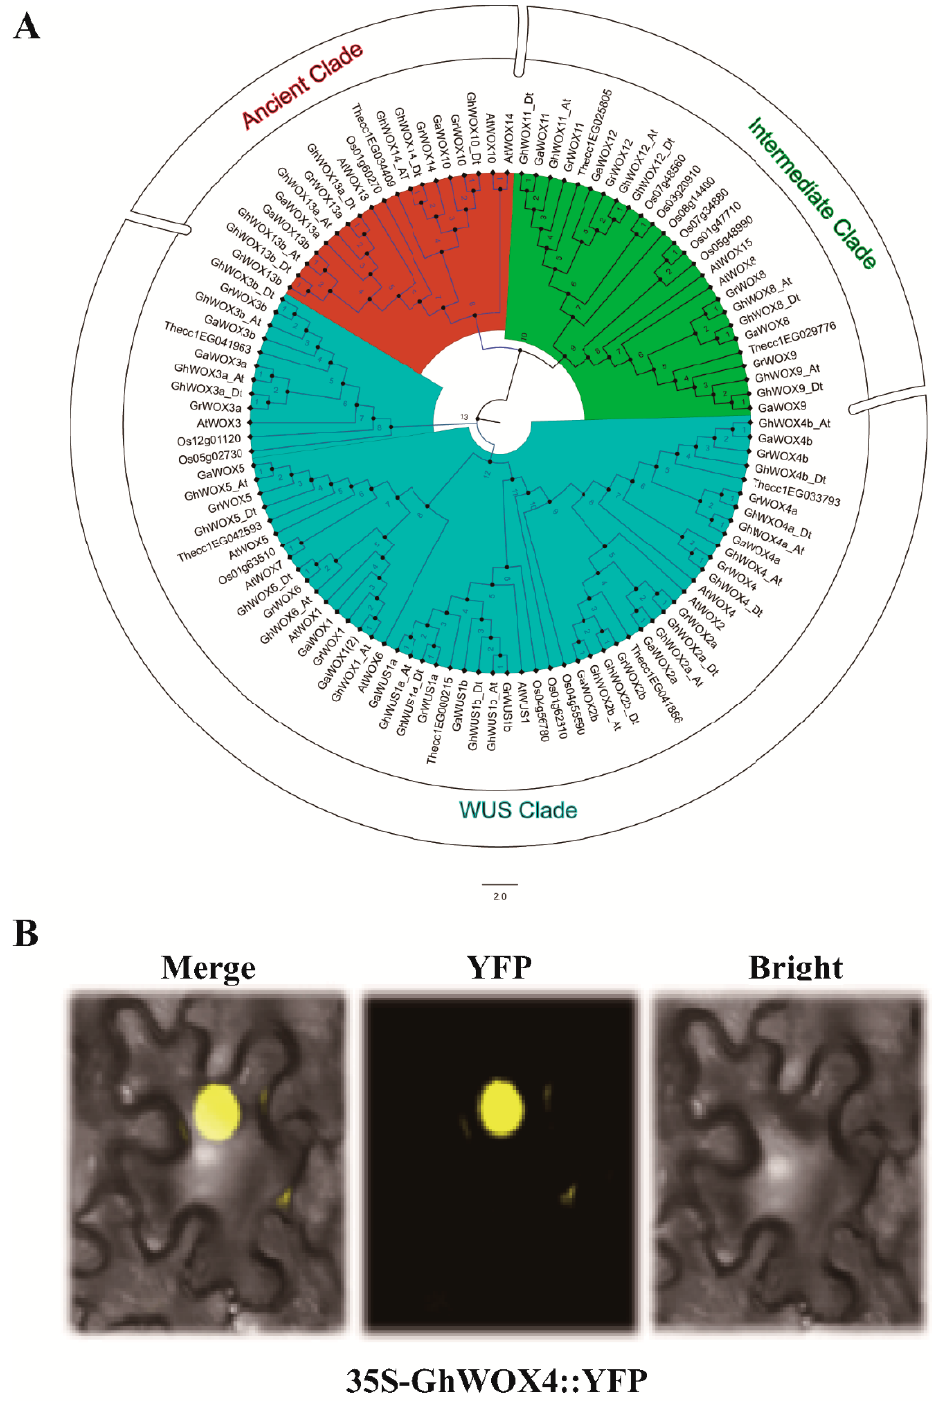
Figure 2. Phylogenetic analysis and subcellular localization. ( A ) Phylogenetic tree representing evolutionary relationship among WUSCHEL-related homeobox (WOX) family genes of different plant species. ClustalX was used to align protein sequences, and Mega-X with neighbor-joining method was used to construct phylogenetic tree. ( B ) Subcellular localization signal of GhWOX4, (YFP) yellow fluorescent protein.